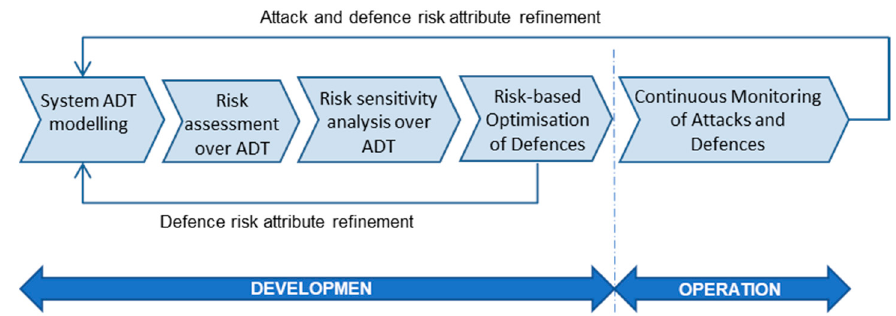
Figure 1. Attack Defense Tree-based continuous quantitative risk management process.